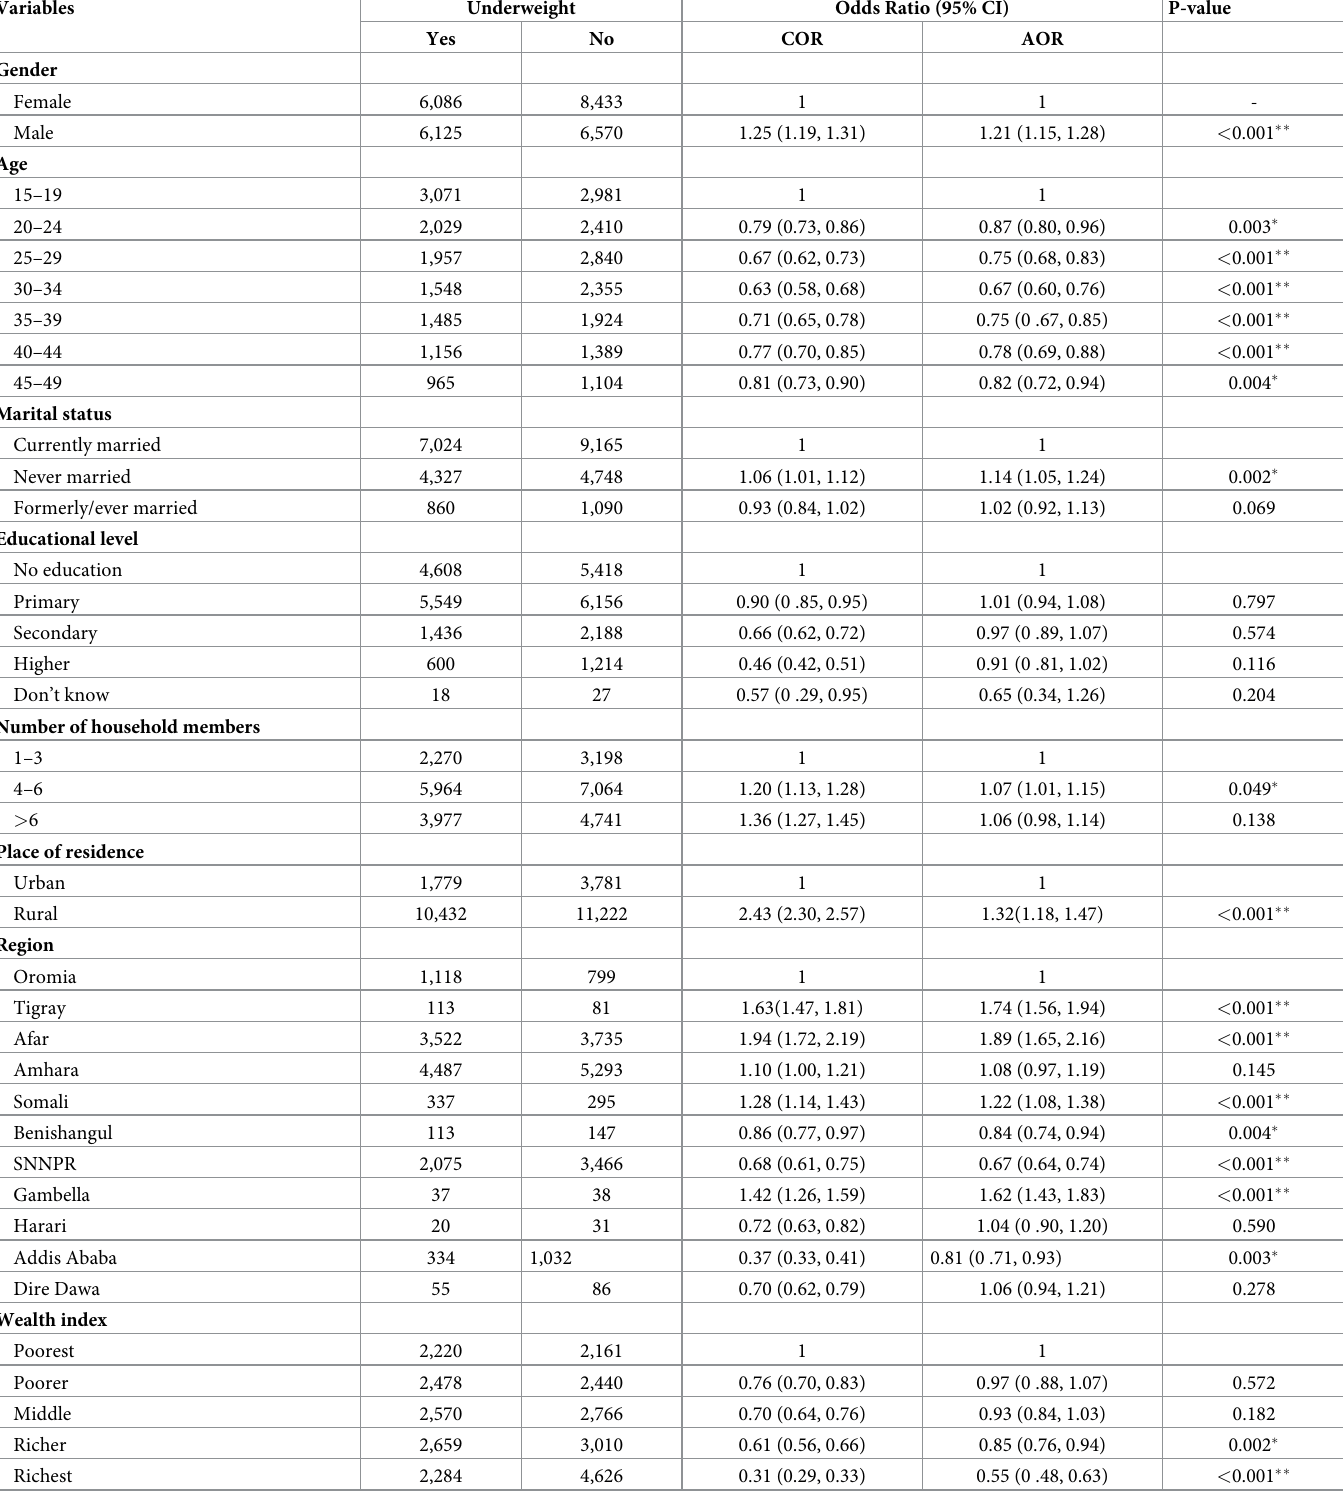
Table 4. Bi-variable and multivariable logistic regression analysis of underweight among individuals age 15–49 years in Ethiopia,